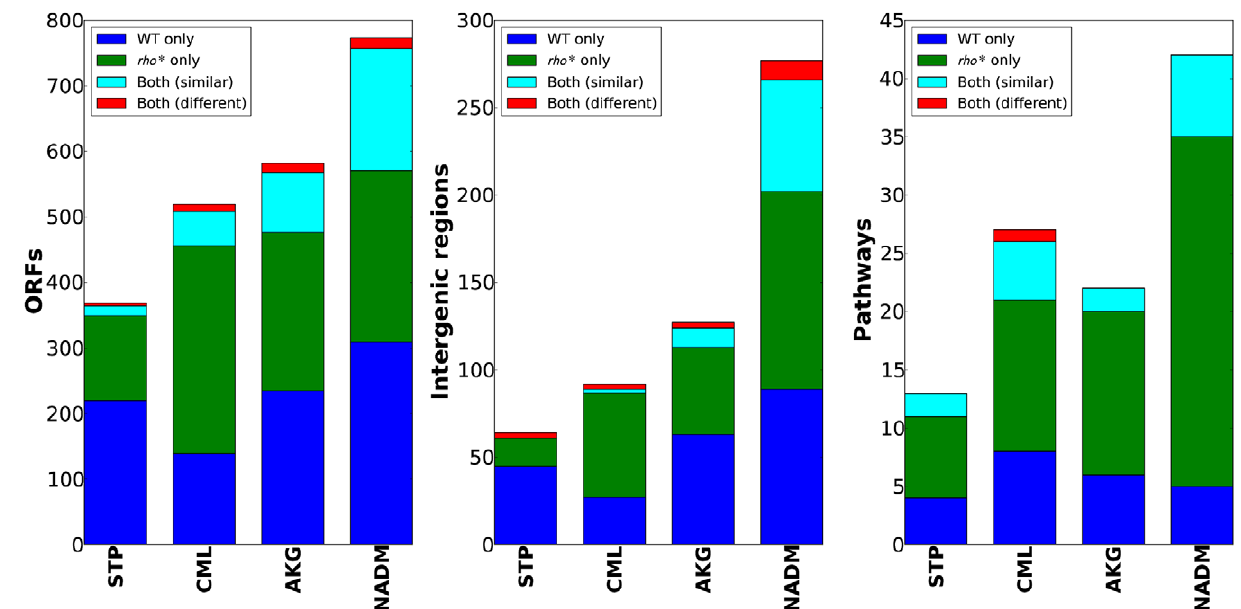
Figure 3. WT and rho * backgrounds show remarkably different fitness landscapes. Bar charts show, from left, the number of genes, intergenic regions, and pathways identified as having informative over- or under-representations of transposon insertions (see main text and Text S1, Section 1.5 for details). Categories which appeared as significant in both WT and rho * data are further subdivided based on whether the pattern of enrichment and depletion was correlated in the two backgrounds.